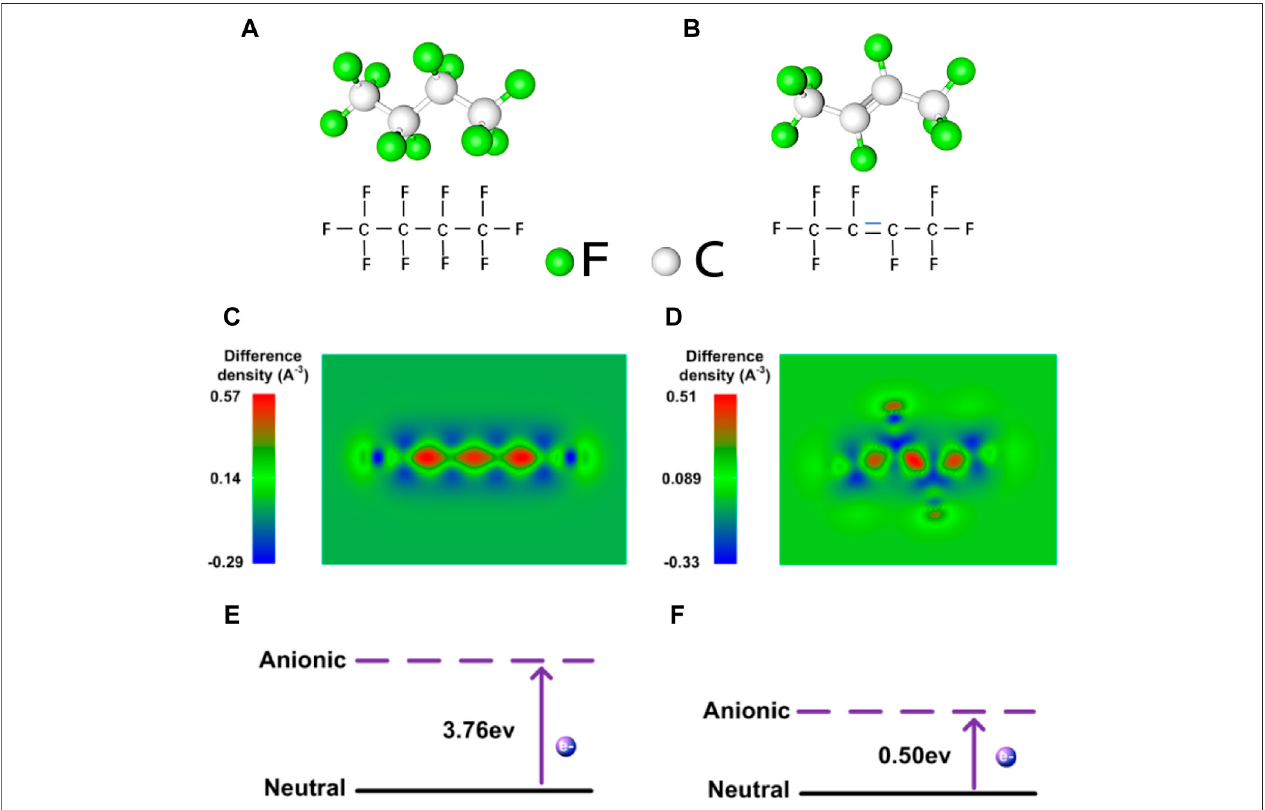
FIGURE 4 | First-principle calculation: (A) The original PTFE molecular (part of the chain); (B) the one after gamma radiation, where some C-F bonds are broken, C=Cbondsformed; (C)(D) comparestheelectrondifferencedensityofthetwomolecularmodels,whichsuggeststhatthechemicalbondchangeleadstothechangeof the electron distribution in the molecular structure, and thus, affect the material ’ s characteristics, such as the electron attracting ability. (E) The fi rst-principle calculation shows that it will take up 3.76 eV energy for the original PTFE molecular to get an electron; (F) The revised molecular will only take up 0.50 eV energy to get an electron. The above experiment implies that the contact electri fi cation between the gamma-ray irradiated PTFE and metal is enhanced, which also implies the CE mechanism is related to the behavior of electrons in the interface.